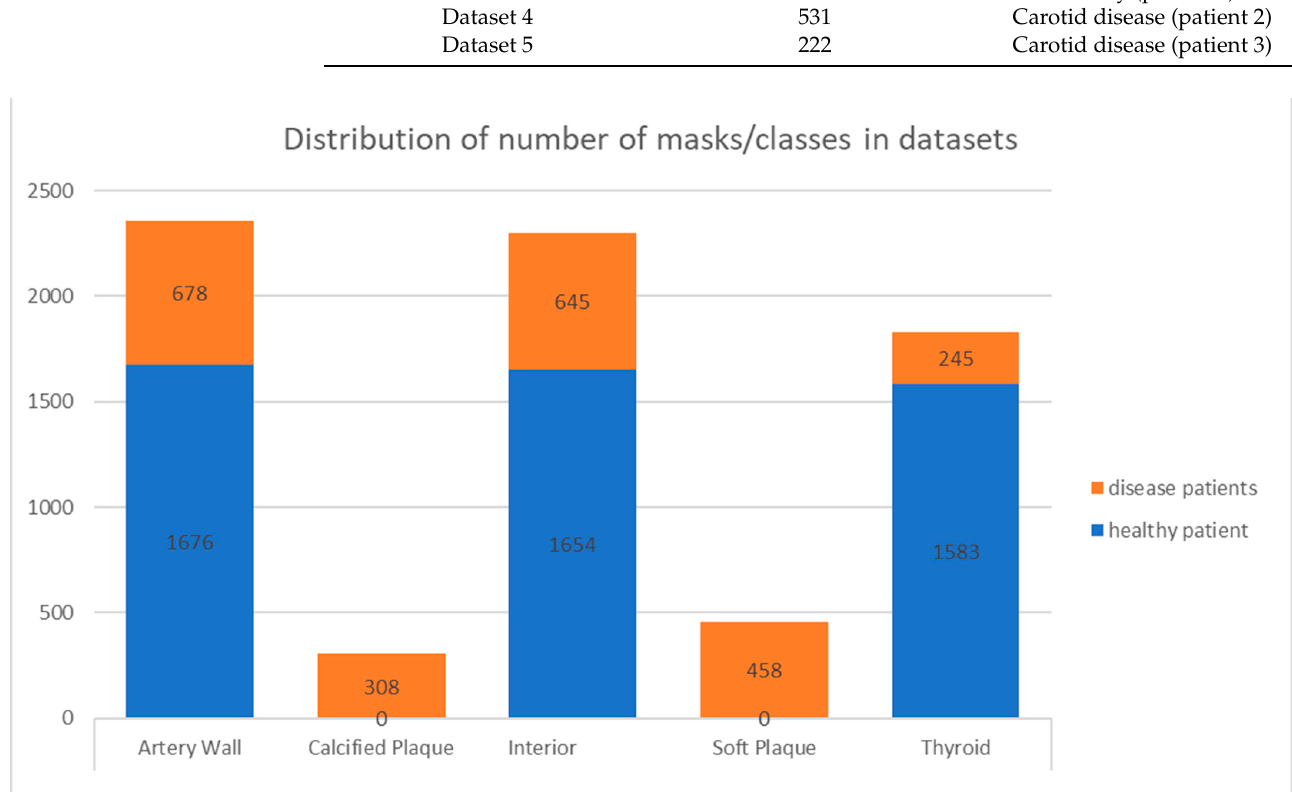
Figure 3. Distribution of number of masks/classes in datasets. Datasets from carotid-artery-disease patients—orange; healthy patients—blue.